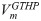
Surface plots of two parameter variation for the sensitive parameters on h2o2 level, nadph/nadp+ ratio, and gsh/gssg ratio.(A-C) Effect of variations in VmGTHP and VmGTHO under normoxic conditions (kmO2 = 164mM). (D-F) Effect of variation in VmGTHP under changing oxygen demand (164mM ≥ kmO2≥ 1mM). (G-I) Effect of variation in VmGTHO under changing oxygen demand (164mM ≥ kmO2≥ 1mM). (J-L) Effect of variation in VmNOX under changing oxygen demand (164mM ≥ kmO2 ≥ 1mM). (M-O) Combined effect of simultaneous variation in VmNOX and VmGTHO under kmO2 = 164mM and kmO2 = 1mM.